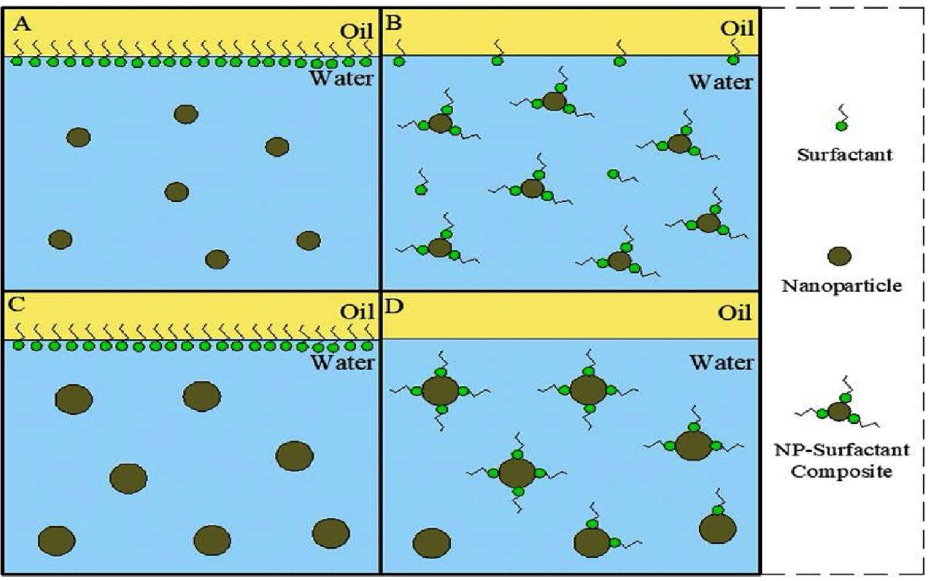
Figure 8. Adsorption mechanism of surfactants at the oil-water interface on NPs surface: ( A , B ) Small size NPs are introduced, where the surfactants’ concentration was enough to achieve optimal miscibility; ( C , D ) Larger NPs are introduced, where the surfactants’ concentration was not enough to reach optimal miscibility.